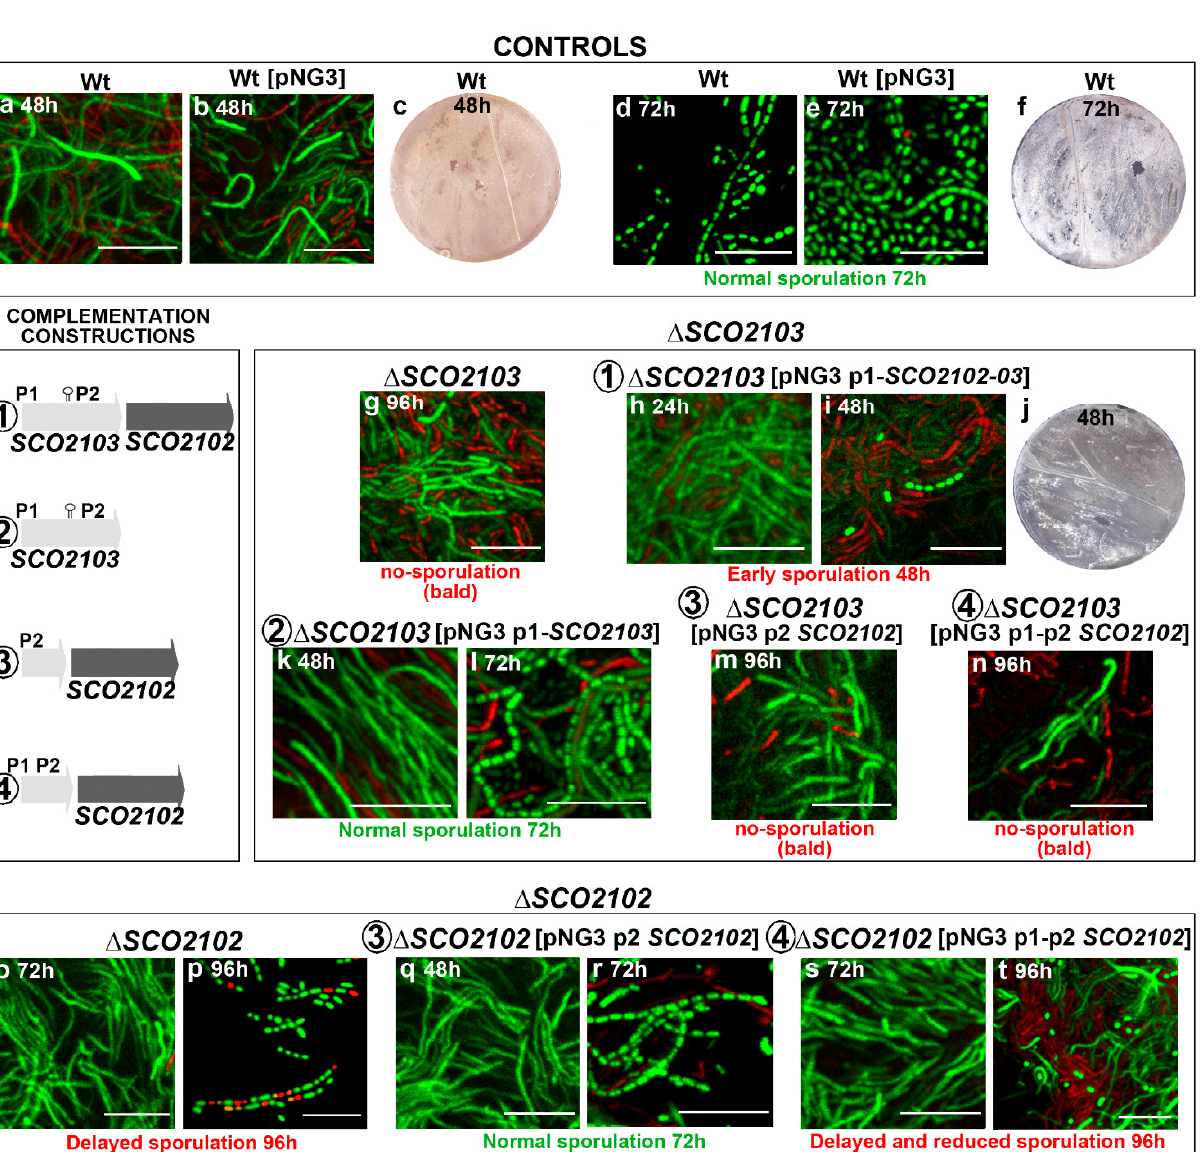
Figure 5. Sporulation timing in GYM solid cultures of the ∆ SCO2102/SCO2103 mutants and their complemented strains. ( a – f ) Control cultures of the wild-type strain with and without pNG3. ( g – n ) ∆ SCO2103 sporulation with and without different combinations of P1, P2 and the SCO2102-03 genes cloned into pNG3. ( o – t ) ∆ SCO2102 sporulation with and without different combinations of P1, P2 and SCO2102 cloned into pNG3. Normal sporulation (72 h culture) is labelled in green. The constructions used to complement the ∆ SCO2102/SCO2103 mutants are outlined and numbered as 1–4. Delayed sporulation is labelled in red. Macroscopic view of the Petri plates (grey colour indicates sporulation), and laser-scanning confocal fluorescence images of hyphae stained with SYTO9 and PI are shown. Representative images from at least three biological replicates are shown. Scale bars indicate 8 µ